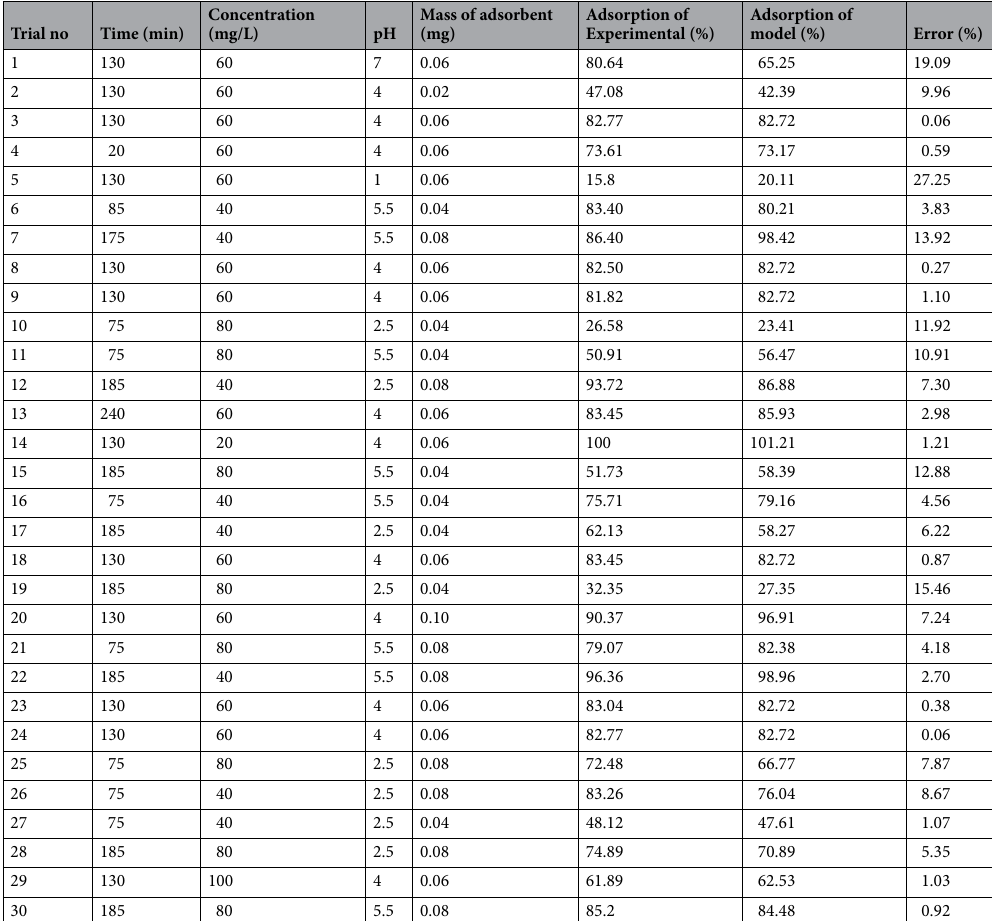
Table 4. The defined CCD layout for four independent variables.